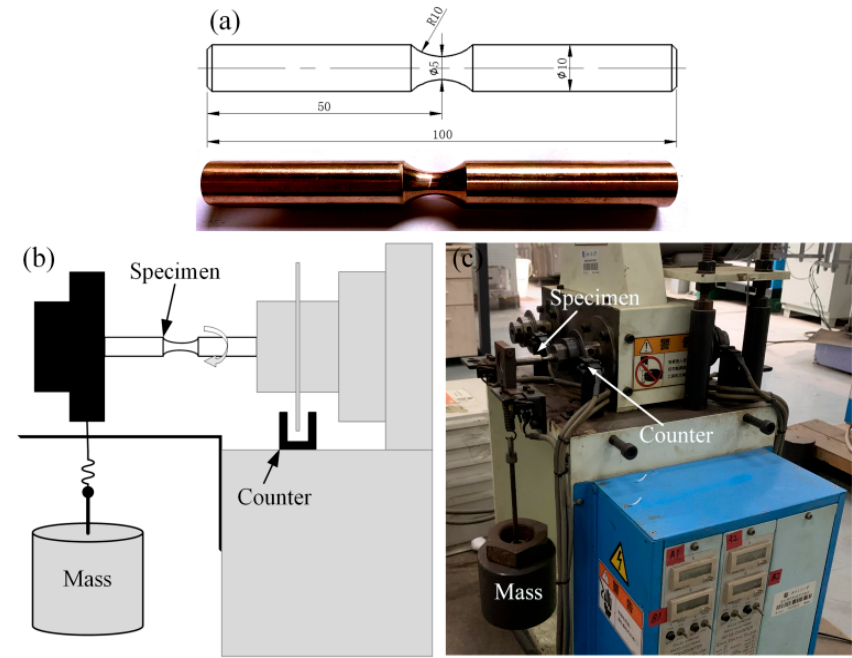
Figure 2. Test equipment: ( a ) Specimen shape and dimensions (units: mm); ( b ) Schematic diagram of the fatigue test; ( c ) Horkos RBE4-3150 rotating bending fatigue test machine. Metals 2020 , 10 , 1267